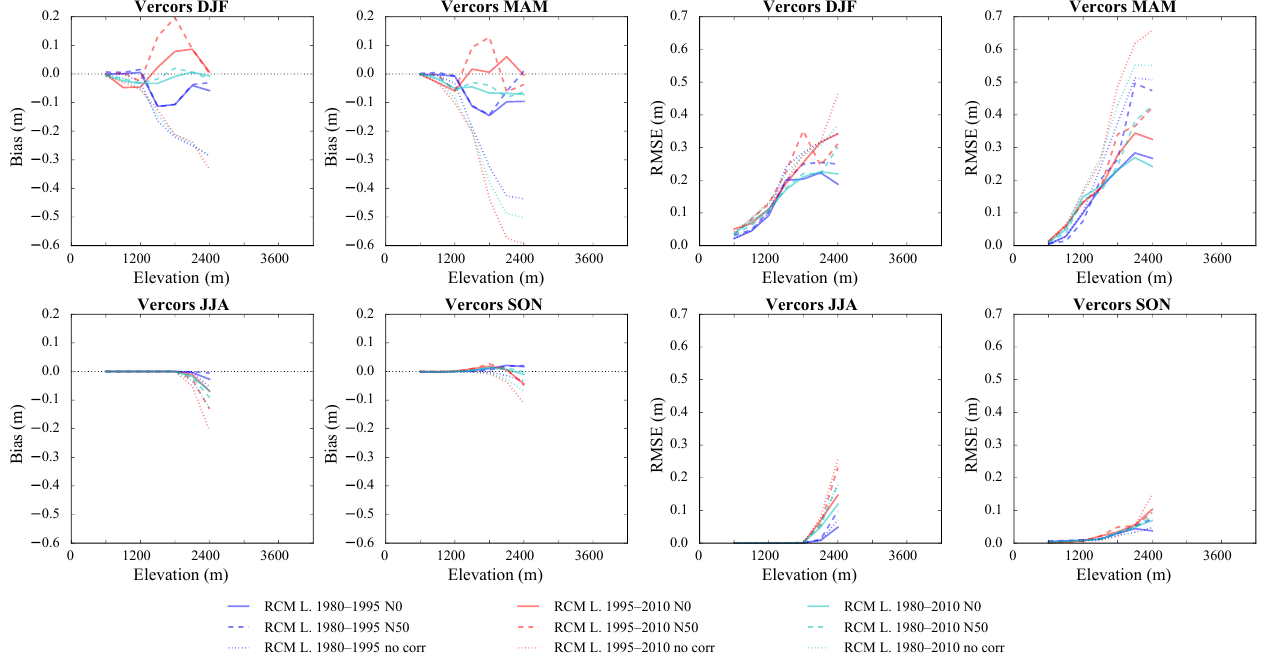
Figure 7. Snow depth mean bias and root mean square error (RMSE) of each adjusted RCM simulation (used as input of Crocus) compared to the SAFRAN/Crocus reanalysis over the evaluation period for the Vercors massif as a function of elevation.